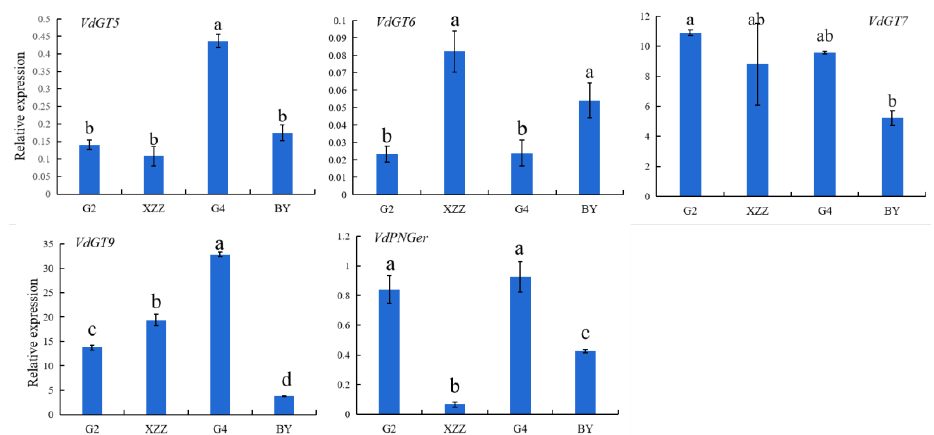
Figure 3. Expression levels of VdGT5 , VdGT6 , VdGT7 , VdGT9 and VdPNGer , which are associated with glycosidically bound volatiles biosynthesis of spine grapes. Values presented are means ± SD ( n = 3). VdGAPDH was used as reference gene. Different letters indicate significant differences among four spine grapes using Duncan’s test ( p < 0.05). G2: Gaoshan #2, G4: Gaoshan #4, XZZ: Xiangzhenzhu, BY: Baiyu.